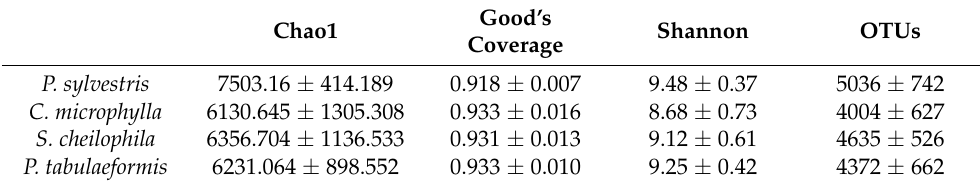
Table 1. Samples’